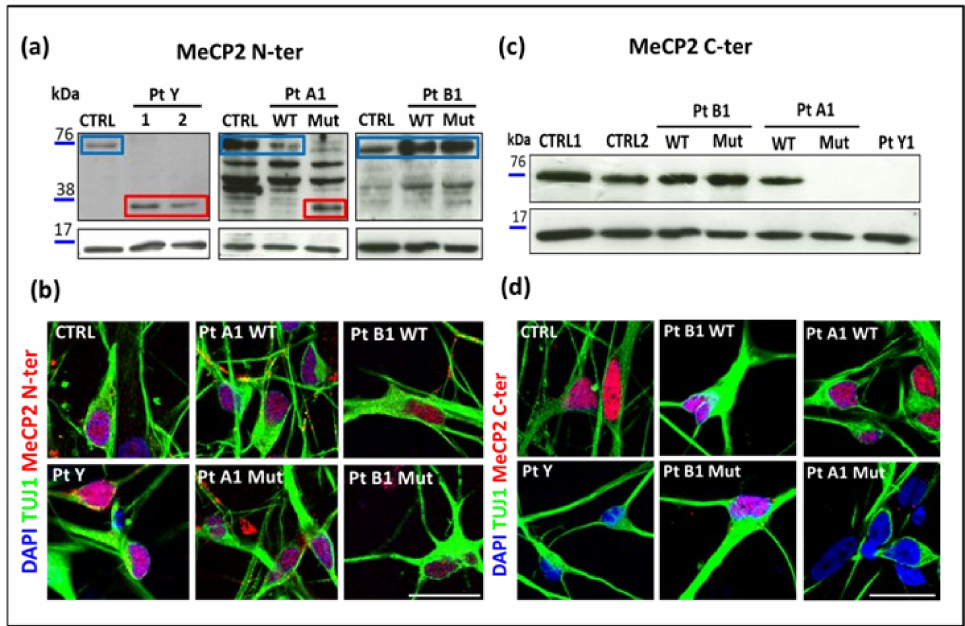
Figure 3. MeCP2 protein in i-neurons from RTT cases with truncating and missense variants. ( a , c ) Western blot on protein extracted from neurons of controls (CTRL), patients carriers of p.Gly252Argfs*7 (PtY), p.Arg255* (PtA1), p.Arg133Cys (PtB1), wild type (WT) and mutant (Mut) isogenic clones, using N-ter antibody (Ab) ( a ) and C-ter Ab ( c ). The blue rectangles frame the band representative of the full-length protein (~75 kDa), while the red ones frame the 37 kDa truncated isoform. Histone H3 (15 kDa) was used as loading control. Panels ( b ) and ( d ) show immunostaining of mature neurons with beta 3 tubulin (TUJ1), highlighting the localization of MeCP2 (red). Nuclei were counterstained with DAPI; scale bar: 20 µ